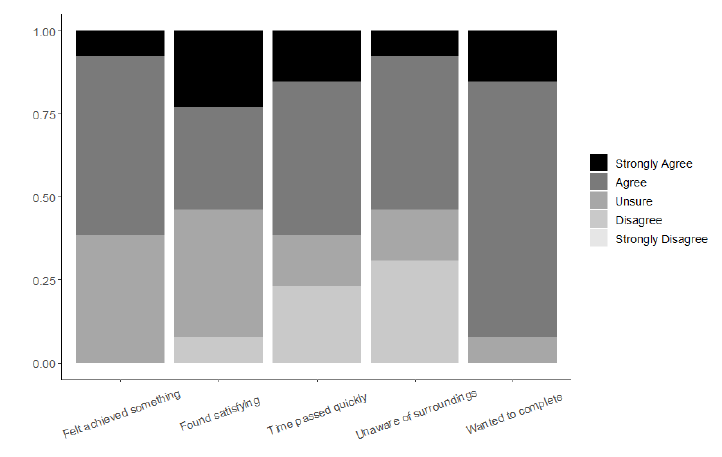
Figure 7. Survey results on tester